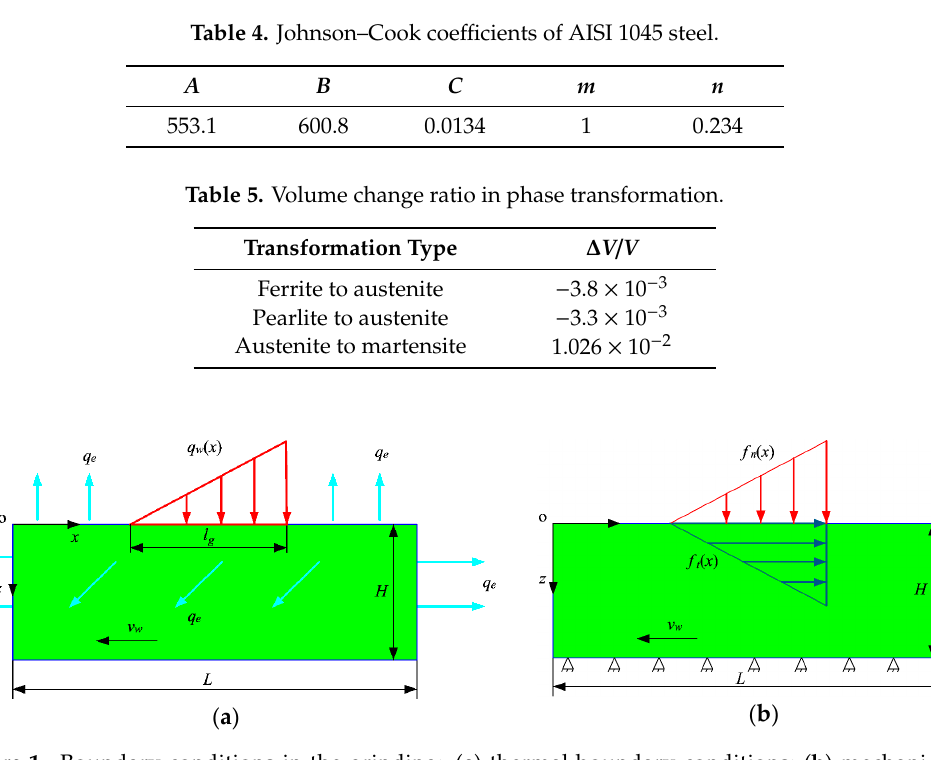
Figure 1. Boundary conditions in the grinding: ( a ) thermal boundary conditions; ( b ) mechanical boundary conditions. H is the height of the workpiece, L is the length of the workpiece, q e is the equivalent heat flux of the convection and radiation.